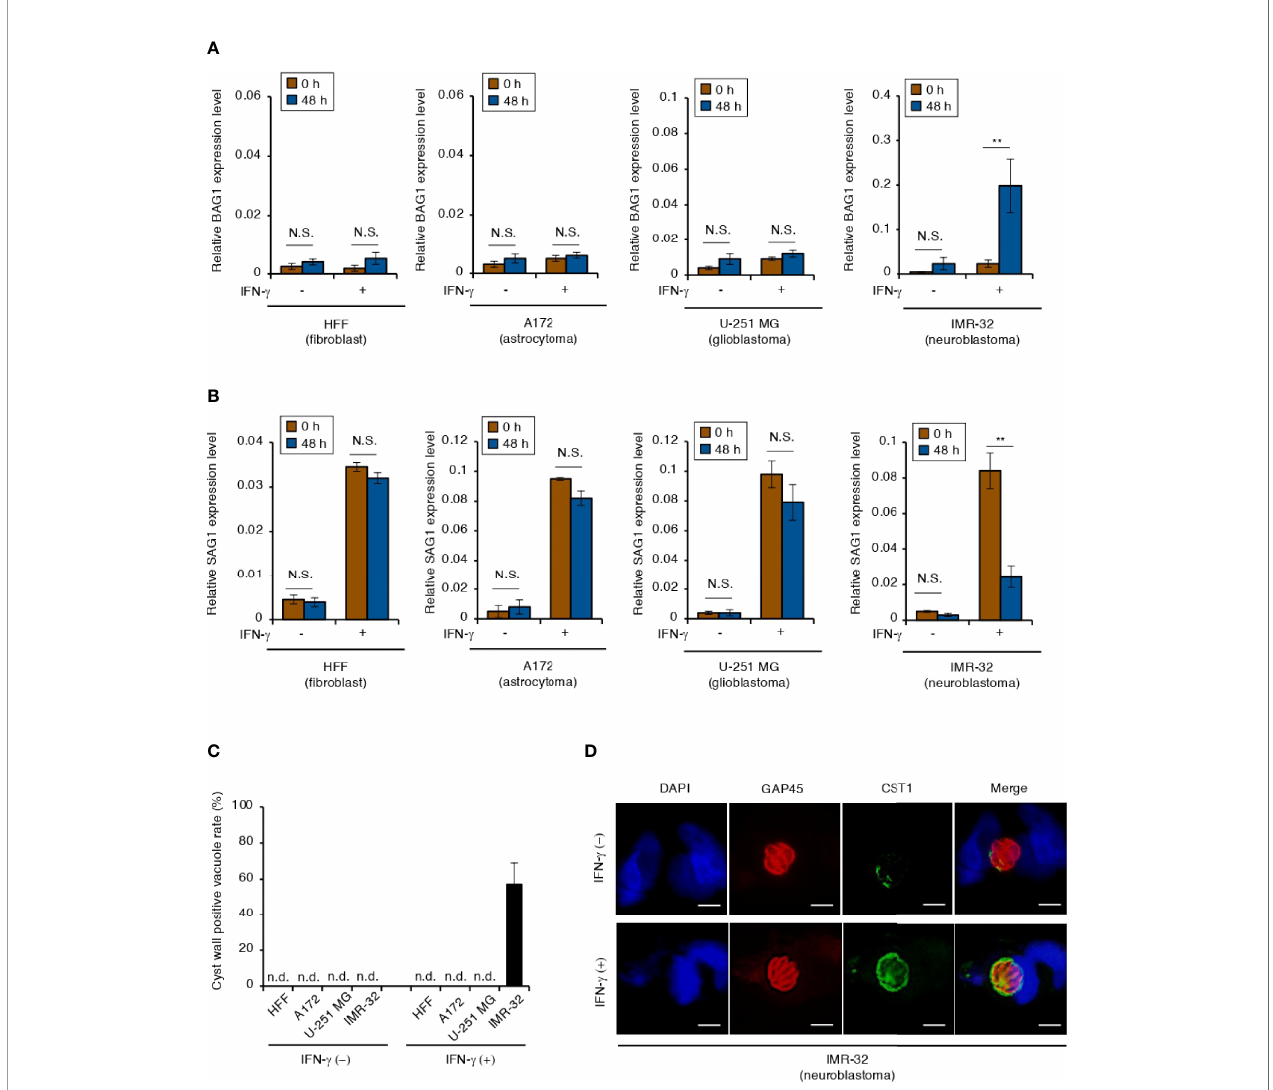
FIGURE 1 | IFN- g stimulation induces T. gondii stage conversion in human neuroblastoma cells. (A, B) HFFs, A172, U-251 MG, and IMR-32 cells infected with T. gondii ME49 were untreated or treated with IFN- g and incubated for 0 or 48 h. Then, the BAG1 (A) or SAG1 (B) mRNA level was analyzed by use of quantitative RT- PCR. (C, D) IMR-32 cells infected with T. gondii strain ME49 were untreated or treated with IFN- g . Cyst wall formation was assessed by IFA at 72 hours post- infection. (C) The percentage of CST1-positive vacuoles was determined. (D) Representative IFA images of T. gondii GAP45 (red) and CST1 (green); nuclei were stained with DAPI (blue). Scale bars correspond to 5 m m. Data are representative of three independent experiments. Indicated values are means ± SD (three biological replicates per group from three independent experiments) (A – C) . ** p < 0.01; N.S., not signi fi cant; n.d., not detected; Student ’ s t